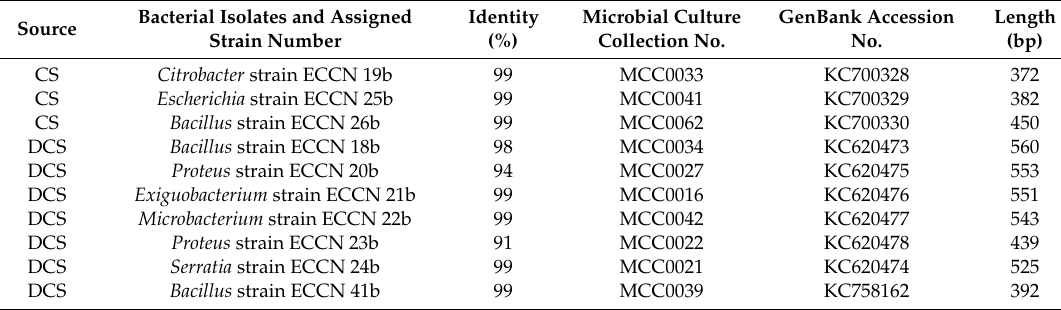
Table 1. Bacterial strains with coal biodegrading activity isolated either from coal slurry (CS) or diesel-contaminated sites